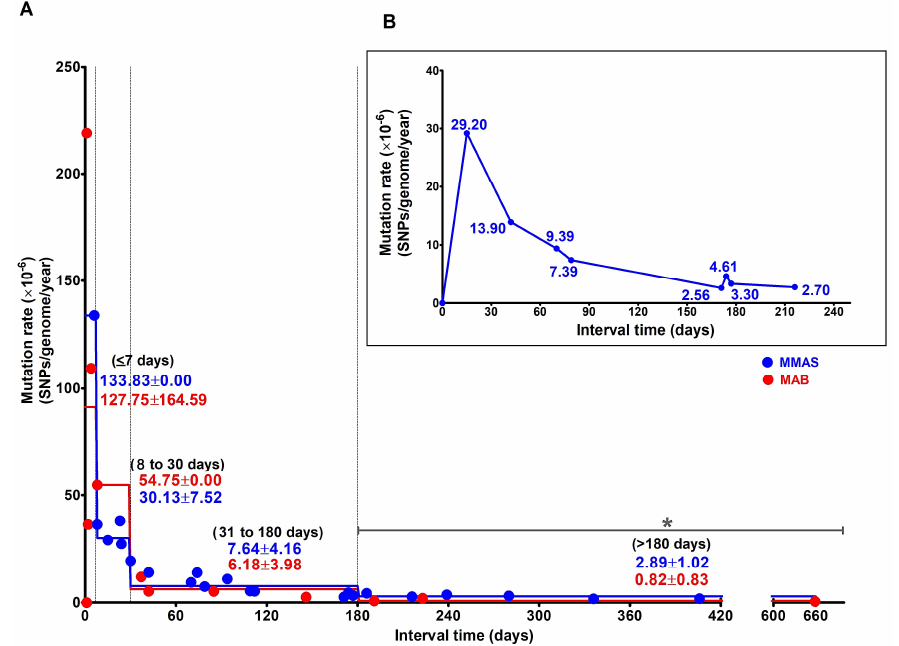
Figure 2. Estimated mutation rates of M. abscessus during persistent infection and persistent col- onization. ( A ) Estimated average M. abscessus mutation rates obtained by comparing numbers of SNPs among strains causing persistent infection and serially isolated at various intervals (25 patients, n = 66 isolates). Data points represent four intervals; ≤ 7 days, 8–30 days, 31–180 days and >180 days to determine M. abscessus mutation rate in two subspecies: MAB (red) and MMAS (blue). The mutation rate of MMAS was significantly higher than MAB at isolation intervals exceeding 180 days. Mutation rates are shown as mean ± SD, * p = 0.01 (independent t -test). ( B ) Average MMAS mutation rate from a single patient with 9 serial isolates (with isolation times of 15 days, 42 days, 70